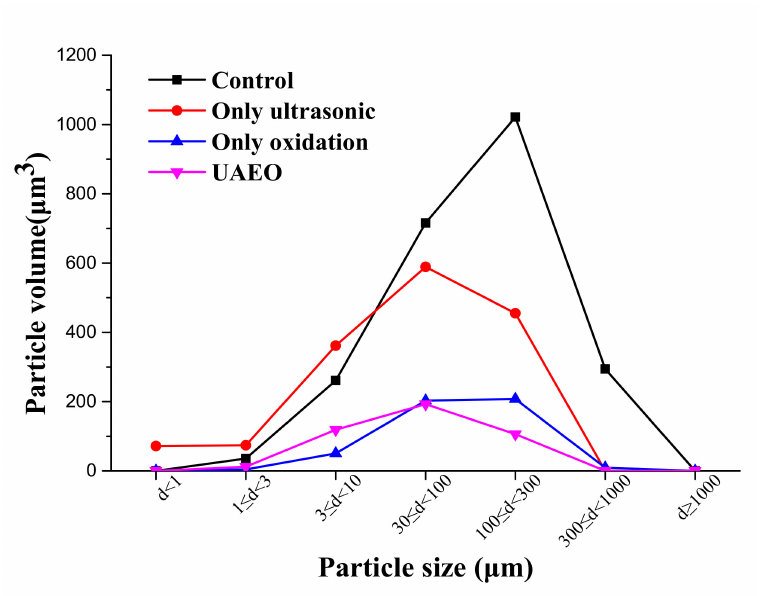
Figure 6. Particle size distribution of undissolved solid matters in the dairy slurry sample after different digestion treatments (45 min).